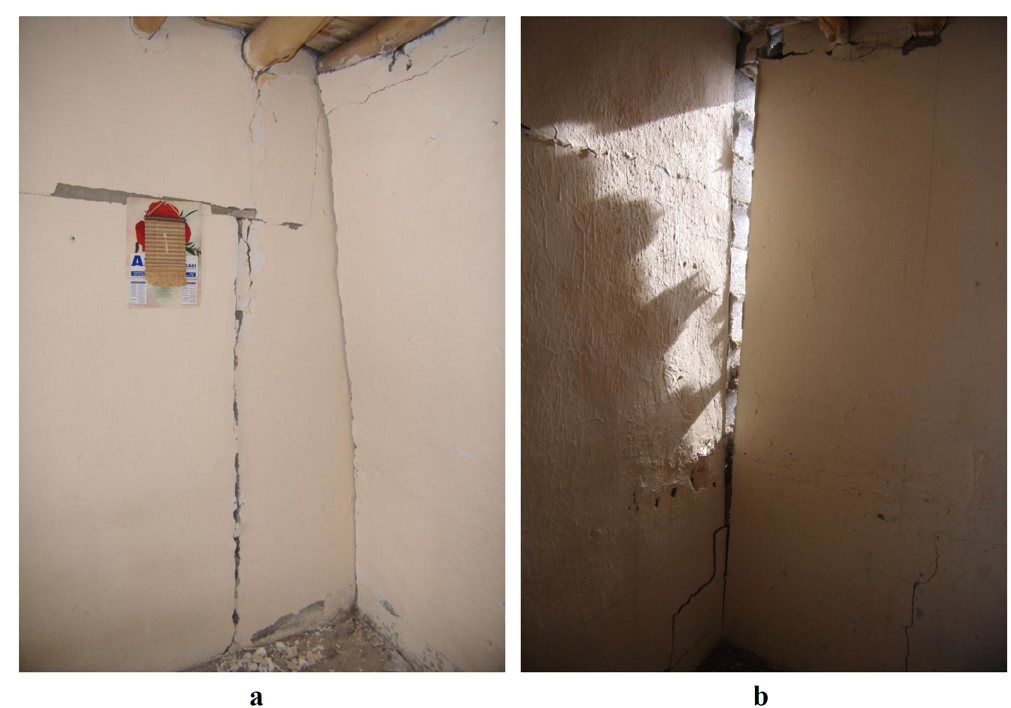
Fig. 14. Severe damages due to overturning moments and developed gaps at the intersections of the bearing